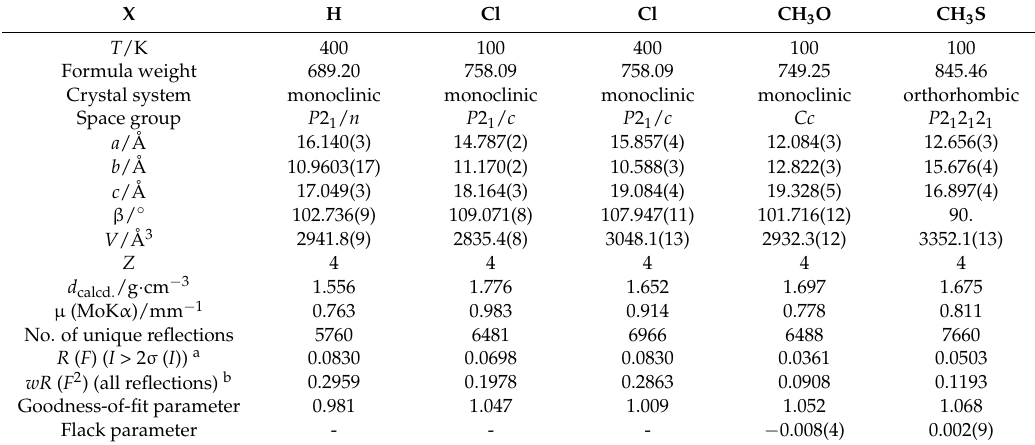
Table 1. Selected crystallographic parameters of [Fe(X-pybox) 2 ](ClO 4 ) 2 (X = H, Cl, CH 3 O, CH 3 S).